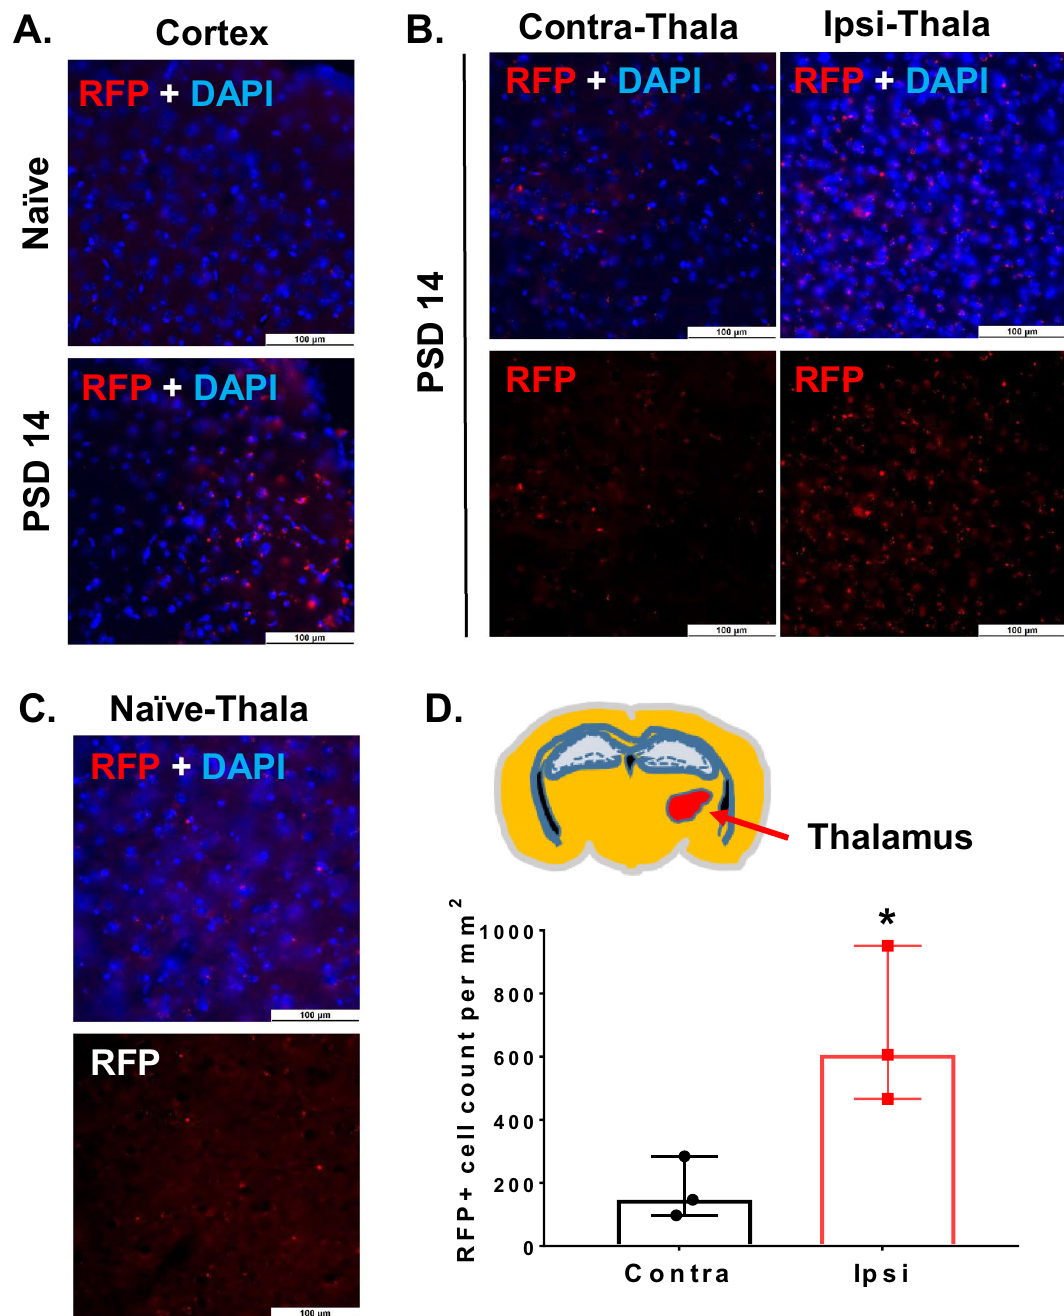
Figure 3. The ipsilateral thalamus demonstrates invasion of peripheral monocytes at PSD 14. CCR2-RFP reporter mice were used to track peripheral monocyte/macrophage invasion into the primary and secondary injury regions. CCR2-RFP mice underwent dMCAO and were evaluated at PSD 14. Representative images showing increased CCR2-RFP + cells within ( A ) primary injury region (cortex) and ( B ) ipsilateral thalamus (20X obj; scale bar = 100 µm). The frequency of CCR2-RFP + cells in contralateral thalamus ( B ) was similar to that of naïve CCR2-RFP reporter mice ( C ). ( D ) Quantification of RFP + cells demonstrating increased CCR2- RFP cells in ipsilateral thalamus (versus contralateral) at PSD 14. * P < 0.05, paired t test. Data expressed as median with 95%